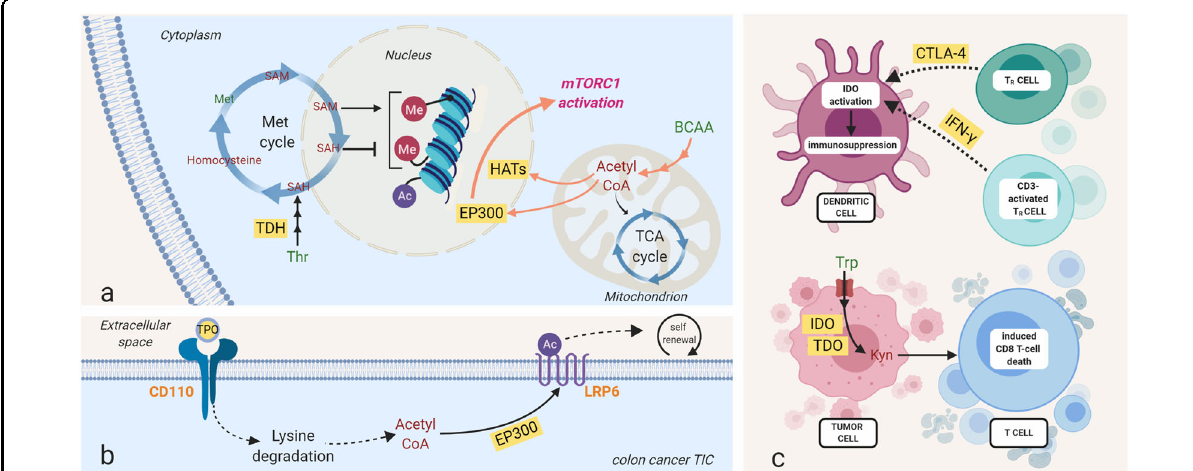
Fig. 3 Amino acids contribute to epigenetic and protein regulation and immunosuppression. a Amino acids provide metabolic intermediates for epigenetic regulation. One-carbon units from the methionine (shown here) and folate cycle serve as a methyl donor for DNA and histone methyltransferases, while acetyl-CoA from BCAAs and leucine can be utilized for histone acetylation. b Amino acid-derived acetyl-CoA is also involved in protein acetylation modi fi cation; a thrombopoietin (TPO)-responsive homodimeric receptor, CD110, activates lysine catabolism, which generates acetyl-CoA for LRP6 (a Wnt signaling protein) acetylation and promotes the self-renewal of tumor-initiating cells of colorectal cancer 24 . c Elevated kynurenine (Kyn) levels originating from tryptophan via the enzymes tryptophan 2,3-dioxygenase (TDO) and indoleamine 2,3-dioxygenase (IDO) have been shown in several cancers, including Hodgkin lymphoma, lung cancer, and ovarian cancer. Kynurenine promotes tumor cell survival by both inducing T-cell death and inducing immune tolerance in dendritic cells (DCs). Methylation and acetylation are represented by red Me and blue Ac circles, respectively. Histone methylation and acetylation are represented by curved lines. DNA methylation is represented by a straight line. Amino acids are in green, and other metabolites are in red. Orange represents receptors. Yellow boxes signify proteins. SAM S-adenosylmethionine, SAH S- adenosyl homocysteine, Met methionine, Thr threonine, BCAAs branched-chain amino acids, Leu leucine, Lys lysine, Acetyl-CoA acetyl-coenzyme A, Trp tryptophan, Kyn kynurenine, IFN- γ interferon gamma, mTORC1 mammalian target of rapamycin complex 1, TDH threonine dehydrogenase, EP300 histone acetyltransferase p300, HAT histone acetyltransferase, CD110 myeloproliferative leukemia protein (thrombopoietin receptor), TPO thrombopoietin, IDO indoleamine 2,3-dioxygenase, TDO tryptophan 2,3-dioxygenase, CTLA-4 cytotoxic T-lymphocyte-associated protein 4, T R cell, regulatory T